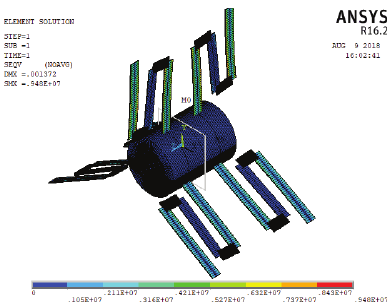
Figure 10. Stress and deformation of the